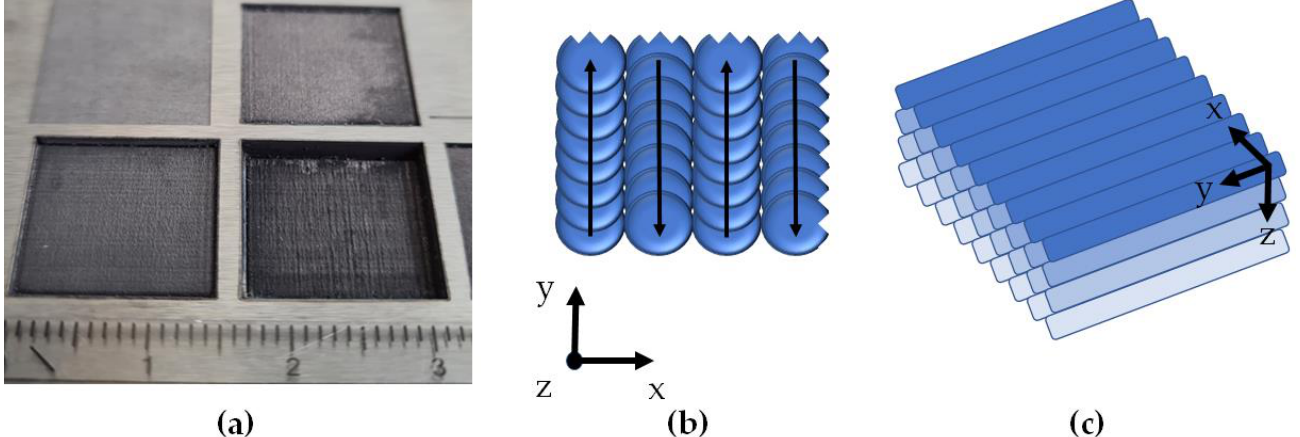
Figure 2. ( a ) The 15 × 15 mm 2 scan areas after USP-laser processing with the microSHAPE TM machine at peak intensities of 1 × 10 15 W/cm 2 and above (see Table 1). The visibly different depths of the processed areas are caused by different numbers of processing steps and variations of the laser pulse energy. The square in the top left corner was processed at PTB with a much smaller peak intensity of 3.0 × 10 14 W/cm 2 . ( b ) Schematic of the 2D bidirectional laser spot movement with respect to the coordinate system as given in Figure 1. In ( c ), multiple processing layers in the z -direction are indicated. Table 1. Summary of laser processing parameters and corresponding measured dose rates for different USP-laser machines and their respective studied configurations. Pulse durations were 1 ps and 0.274 ps, and laser focus spot diameters were 12 µ m and 33 µ m (both manufacturer information) for the setups operated at SCHOTT AG and at PTB, respectively. The wavelengths of all lasers listed here were approximately 1 µ m. The maximum ambient dose rate measurements at SCHOTT AG were conducted at a distance of 475 mm from the laser processing location. The maximum ambient dose rate at the GL.evo machine of approximately 2.1 mSv/h was measured at a distance of 160 mm during a laser turning process. The uncertainties listed for the dose rate values were calculated via error propagation of the calibration factor of the dosemeter. USP-Laser Machine